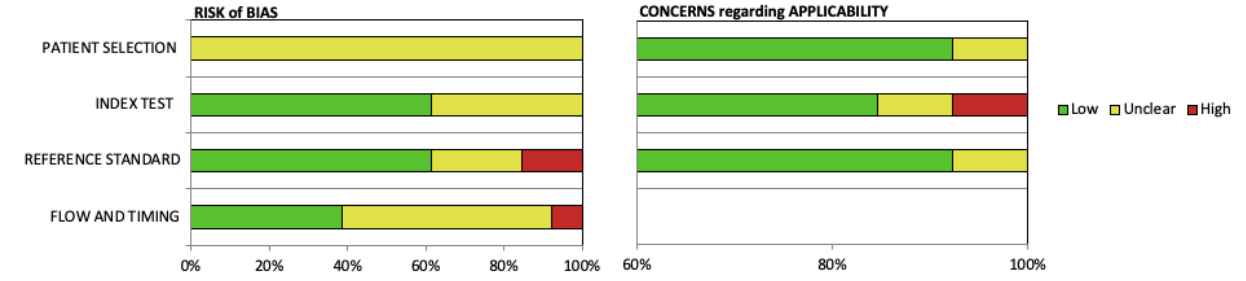
Figure 4. QUADAS-2 grading of article risk of bias and concerns regarding applicability (n = 13).